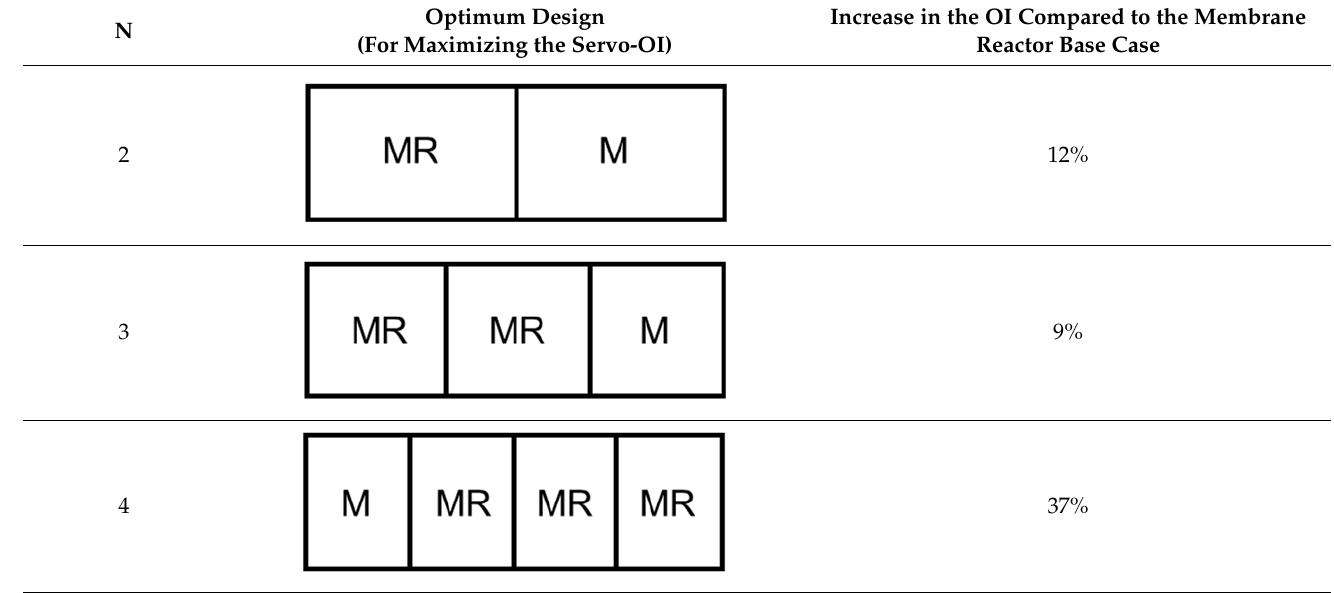
Table 3. Summary of the operability and optimization analyses for maximizing the servo ‐